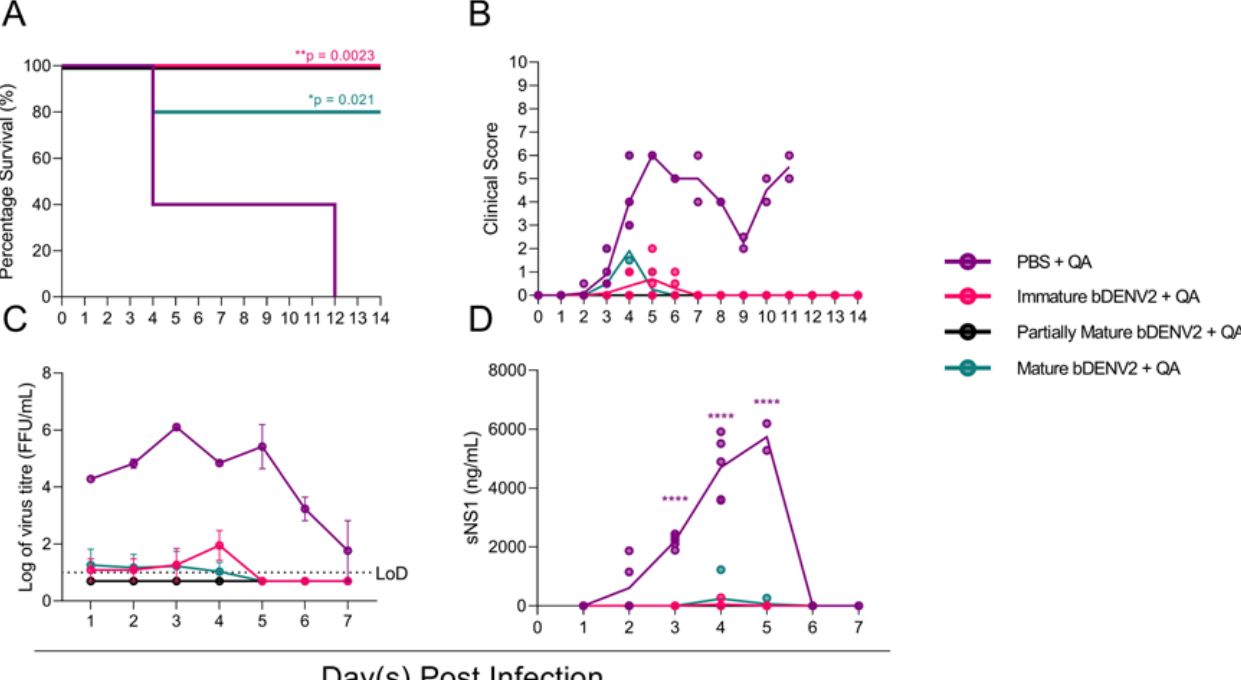
Figure 3. Survival, clinical score, viremia, and sNS1 levels in AG129 mice following DENV-2 D220 challenge. ( A ) Survival curve of mice immunized with bDENV-2 or PBS and challenged with 5 × 10 5 FFU of DENV-2 D220 via i.p. injection. ( B ) Mice were observed for 14 dpi and were scored based on their locomotion, appearance, and behavior; each dot represents scores for the individual mice. Viremia ( C ) and sNS1 ( D ) were quantified by immunoplaque assay and NS1-capture ELISA. Virus titres of each mouse were determined and displayed as the mean ± SEM. Dotted horizontal line indicates a lower limit of detection (LoD). Statistical significance was determined using a log-rank (Mantel–Cox) test for survival compared to PBS + QA vaccination. The log10-transformed virus tires and sNS1 levels were analyzed using one-way ANOVA with Tukey’s multiple comparisons test. **** p < 0.0001, ** p ≤ 0.002, * p ≤ 0.03, ns p ≥